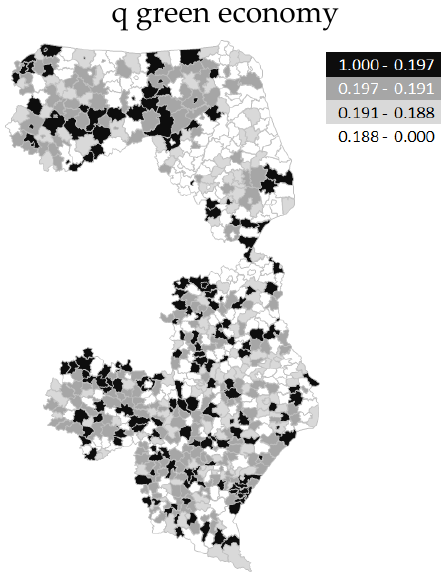
Figure 10. Concentration of the synthetic measure, waste management and green economy in communes of Eastern Poland in 2010–2020 (Gini’s coefficient). Source: own study.